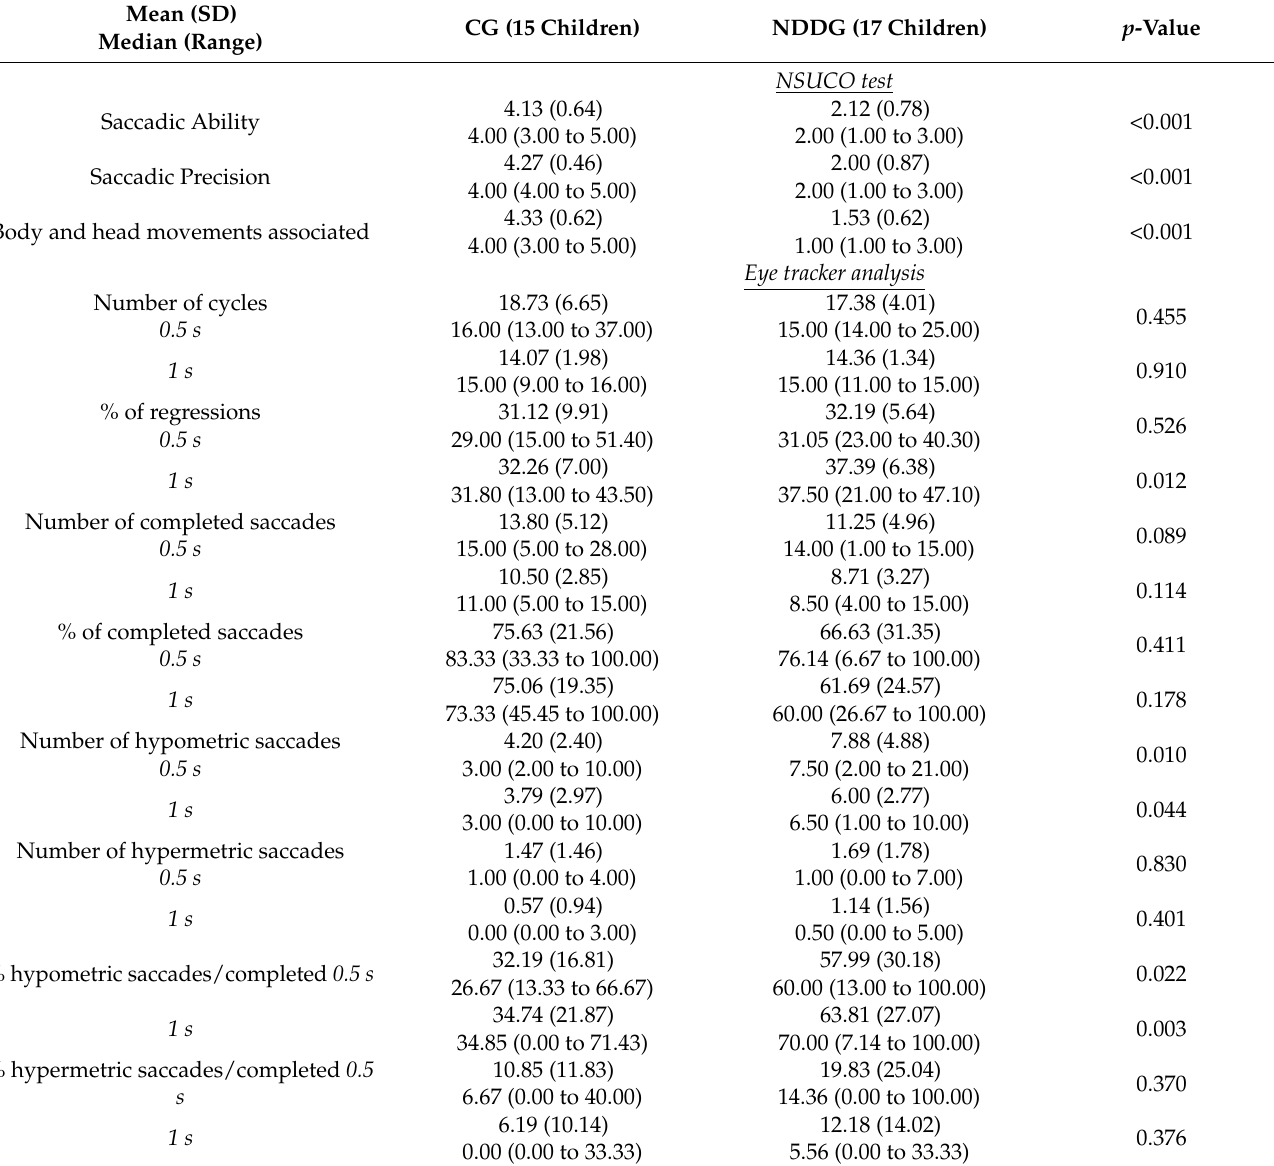
Table 3. Summary of the outcomes of the oculomotor examination in the two groups involved in the study: CG, control group, and NDDG, neurodevelopmental disorder